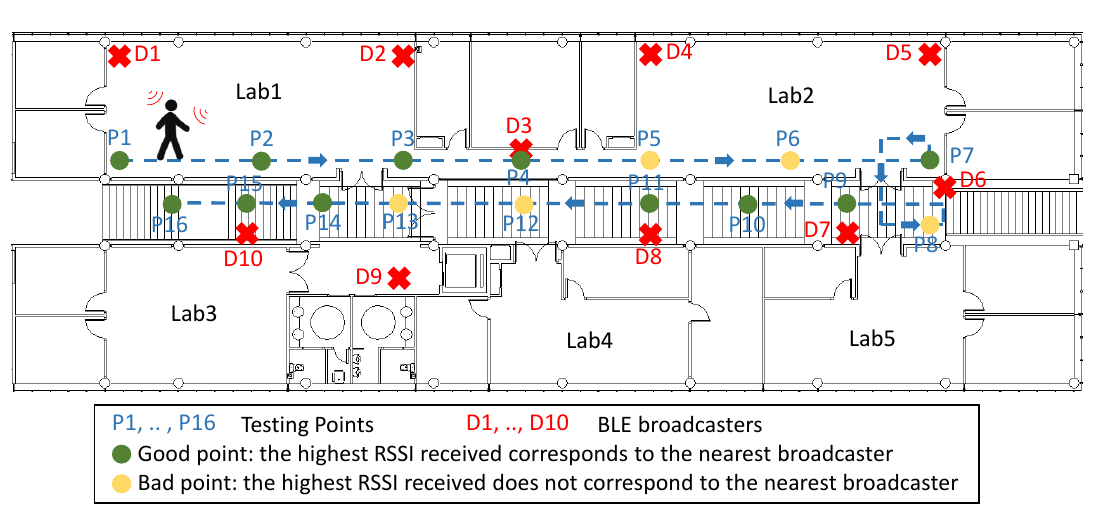
Figure 9. Results obtained in preliminary test to check the performance in a BLE IoT